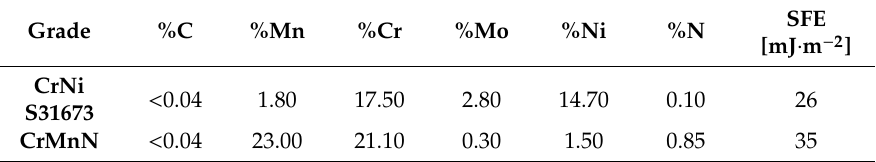
Table 1. Chemical composition of the test grades in wt%.